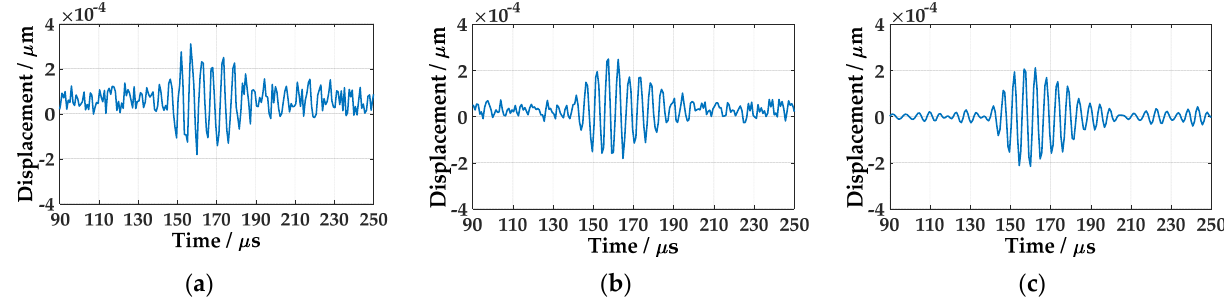
Figure 7. The wave at 40 mm in CFRP plate: ( a ) Single acquisition signal; ( b ) Average of 32 acquisitions; ( c ) After filtering.